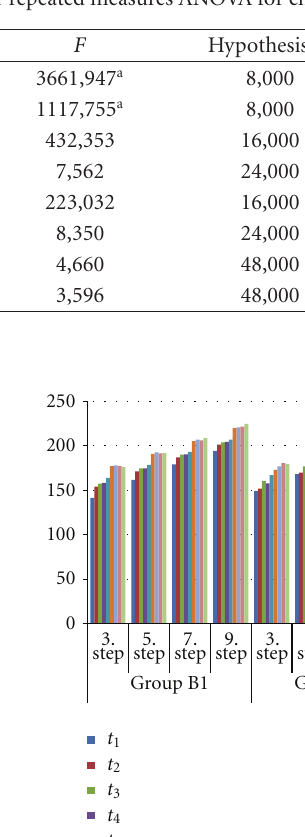
Figure 3: The MGVs of the three subgroups of the D¨urr Dental plates according to delay in scanning time.